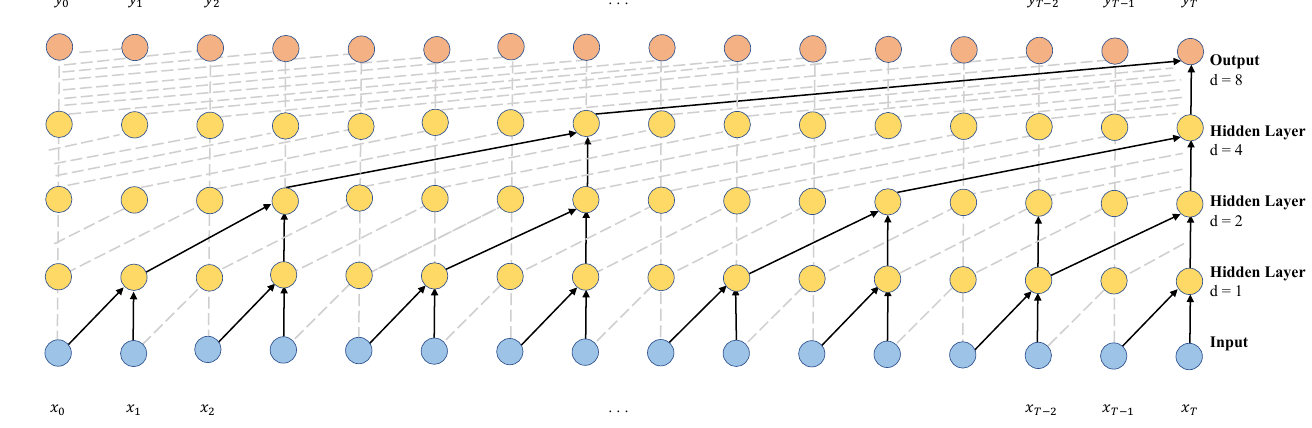
Figure 4. Visualization of a stack of dilated causal convolutional